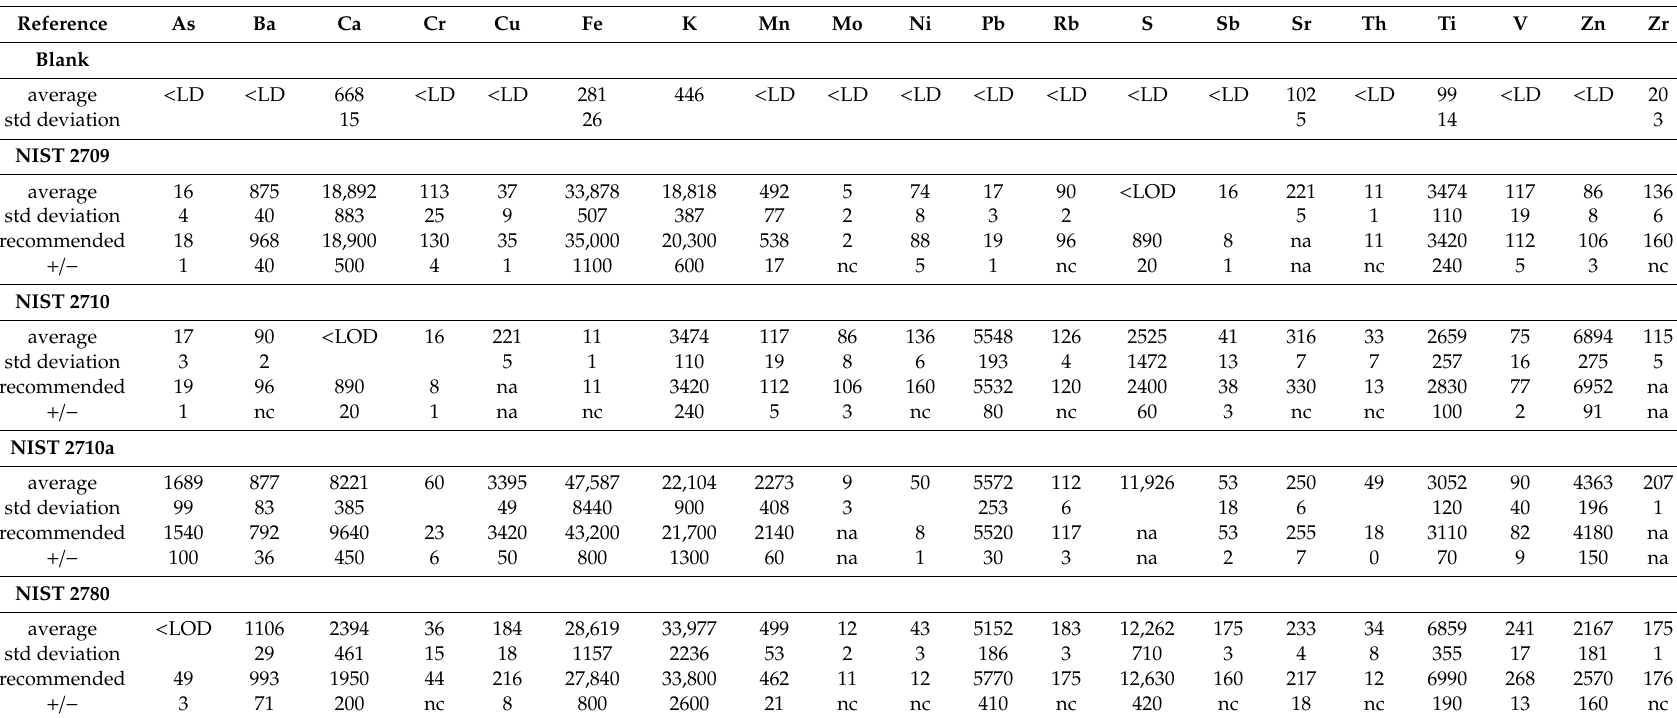
Table 5. Blank and CRM (soil and waste) pXRF measurements (mg / kg). na: not available, nc: not calculated